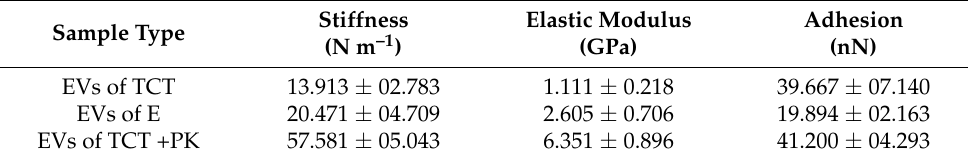
Table 1. Nanomechanical properties of EVs of TCT, EVs of E and EVs of TCT after the treatment with proteinase K *.